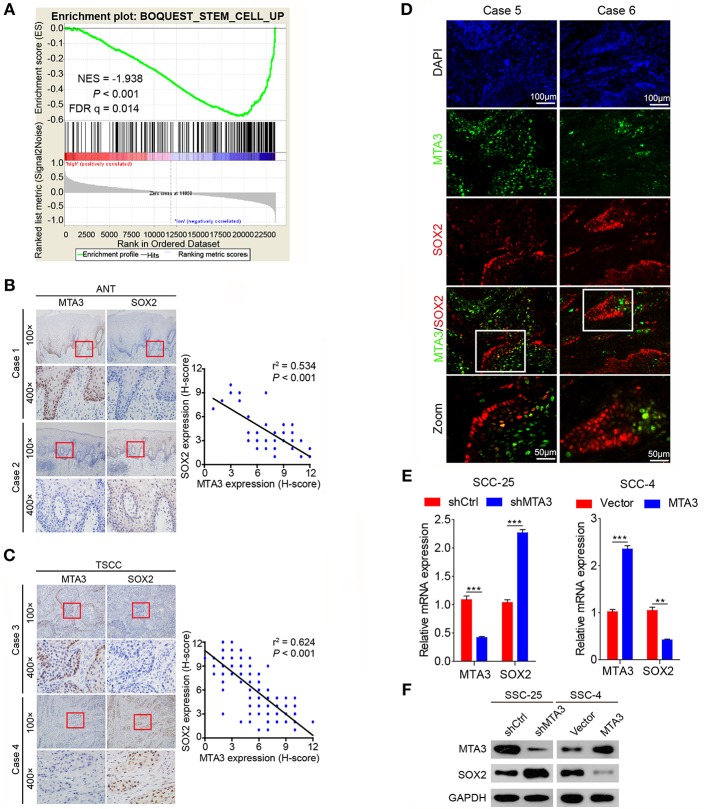
MTA3 represses key TSCC plasticity regulator SOX2. (A) GSEA plots of enrichment of BOQUEST_STEM_CELL_UP signatures in MTA3High tumors vs. MTA3Low tumors in the GSE78060 dataset. (B) Representative IHC image against MTA3 and SOX2 of normal tissues (left panel), Pearson's correlation analysis of MTA3 and SOX2 IHC intensity in 119 adjacent non-tumor tissues (ANT) (right panel). (C) Representative IHC image against MTA3 and SOX2 of TSCC tissues (left panel), Pearson's correlation analysis of MTA3 and SOX2 IHC intensity in 119 TSCC tissues (right panel). (D) Representative double immunofluorescence of MTA3 and SOX2 in TSCC patient tissues. DAPI = blue, MTA3 = green, SOX2 = red. (E) qRT-PCR of MTA3 and SOX2 in SCC-25 cells with MTA3 depletion (Left panel) and SCC-4 cells MTA3 overexpression (Right panel), **P < 0.01 and ***P < 0.001 using student's t-test. (F) Western blot of MTA3 and SOX2 in SCC-25 cells with MTA3 depletion (Left panel) and SCC-4 cells with MTA3 overexpression (Right panel).